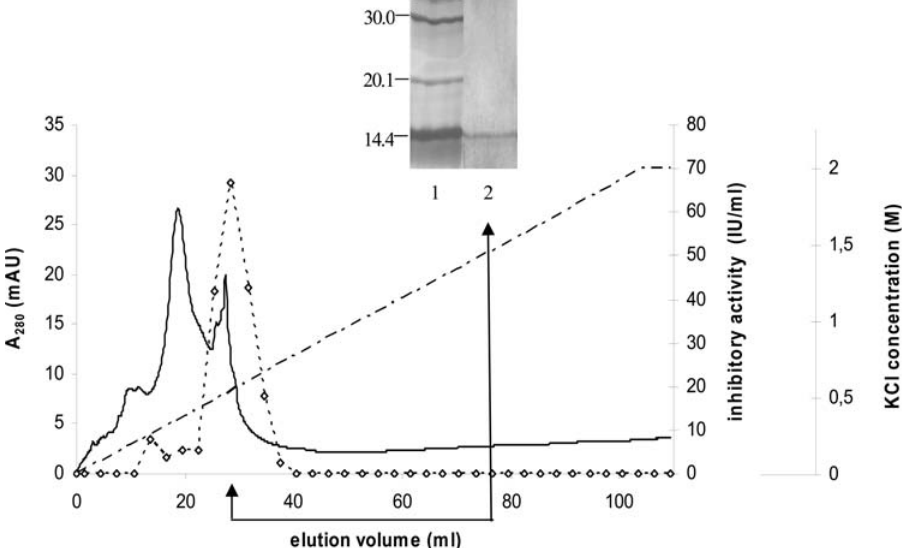
Figure 1. Purification of PliC from S. Enteritidis periplasmic extract by HEWL-affinity chromatography. Protein concentration in eluate was monitored by absorption at 280 nm [A 280 ] and expressed in milli absorption units [mAU] (—), inhibitory activity of fractions against HEWL was monitored by inhibitor assay (- e -). Elution was done with a gradient of 0–2.0 M KCl in 0.1 M Tris, pH 12.0 ( ?2?2? ). Photograph in inset shows SDS- PAGE gel with molecular weight markers (lane 1, and indices in kDa at the left) and a concentrated fraction containing 0.163 mg/ml protein (without BSA addition) and an inhibitory activity of 323 IU/ml, corresponding to a specific activity of 1982 U/mg (lane 2).